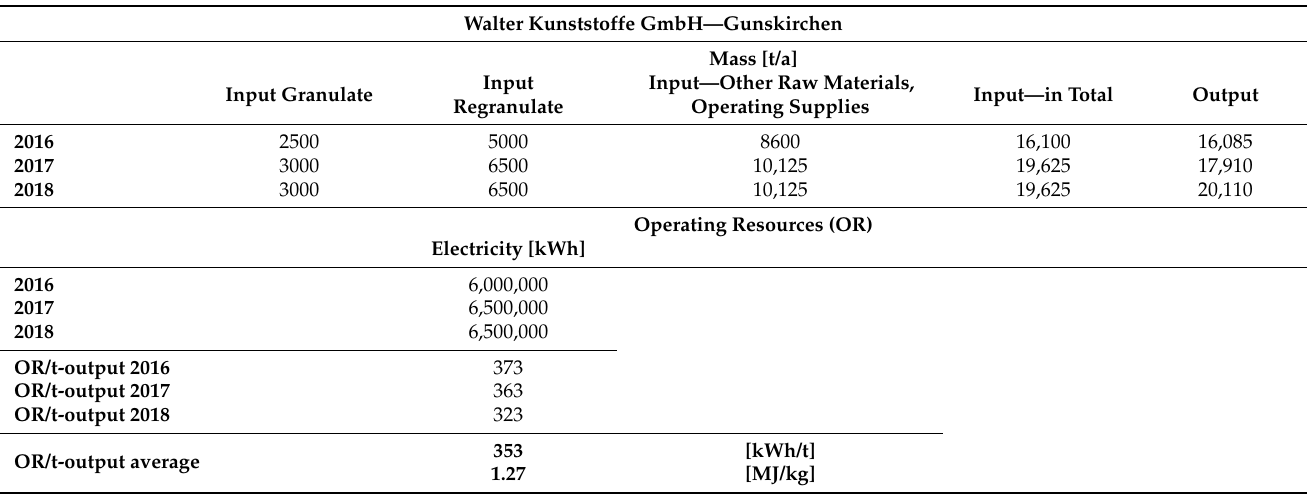
Table A1. Production data of the film manufacturing process as a data basis for packaging production